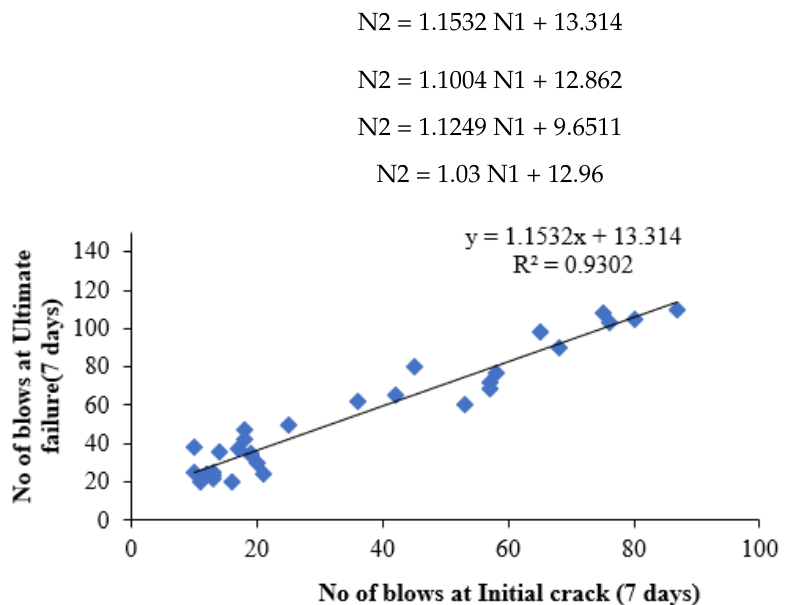
Figure 13. Prediction of ultimate impact resistance at 7 days.